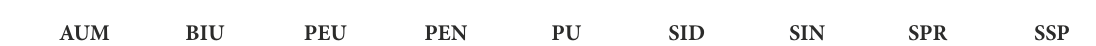
TABLE 4 Discriminant validity evaluation for the reflective variables by HTMT criterion.